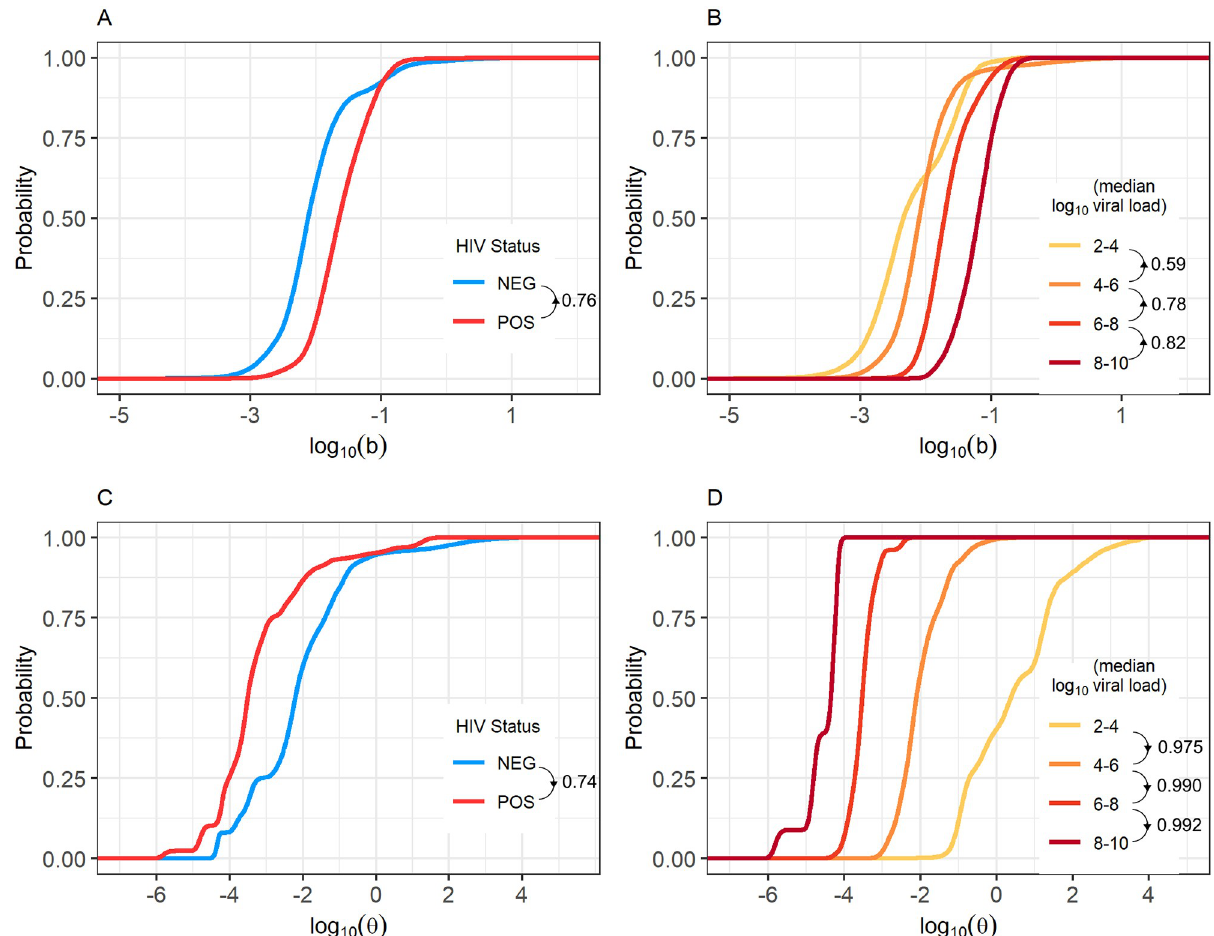
Fig 5. Cumulative distribution of parameters b and θ , stratified by HIV-1 status and median EBV viral load in saliva. Fitting our mathematical model to participant data revealed that parameter b is usually greater in HIV-1 coinfected participants (A) and increases with median EBV viral load (B). Parameter θ is usually lower in HIV-1 coinfected participants (C) and decreases with median saliva EBV viral load (D). Directional arrows and numbers by figure legends indicate the probability that a randomly selected individual of one group has a higher parameter value (be it b or θ ) than a randomly selected individual in a second group. Arrows show the direction of